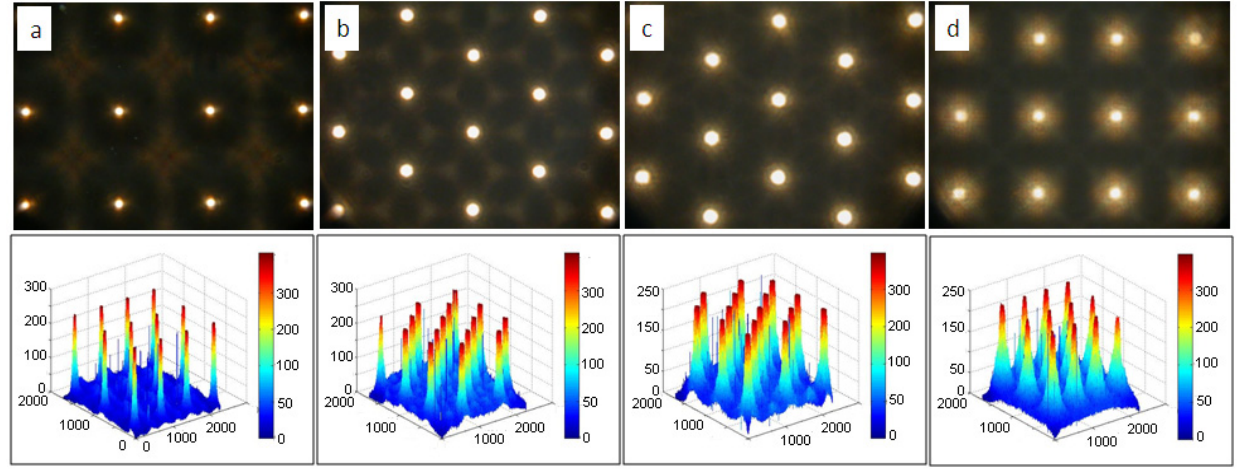
Figure 7. The focused spot images (above) and their intensity distribution (below) of (a) circular lens quadratic grid MLA, (b) circular lens hexagonal grid MLA, (c) hexagonal lens MLA, and (d) square lens